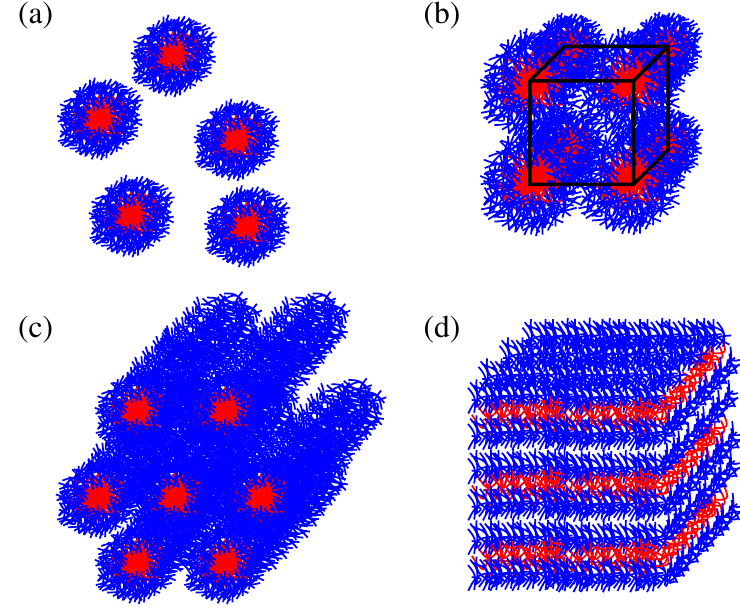
Figure 1. Schematic drawings of the micellar ( a ), cubic ( b ), hexagonal ( c ) and lamellar ( d ) structures of Pluronic BCPs in selective solvents.